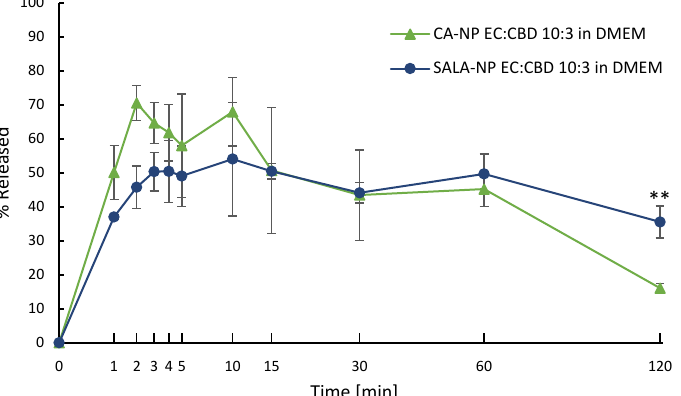
Figure 4. CBD release from LSNs in DMEM cell culture medium, ** p value < 0.01 between CA-NP and SALA-NP (calculated as a 2-tailed homoscedastic Student’s t -test) at 120 min interval. Values are presented as mean ± SD.